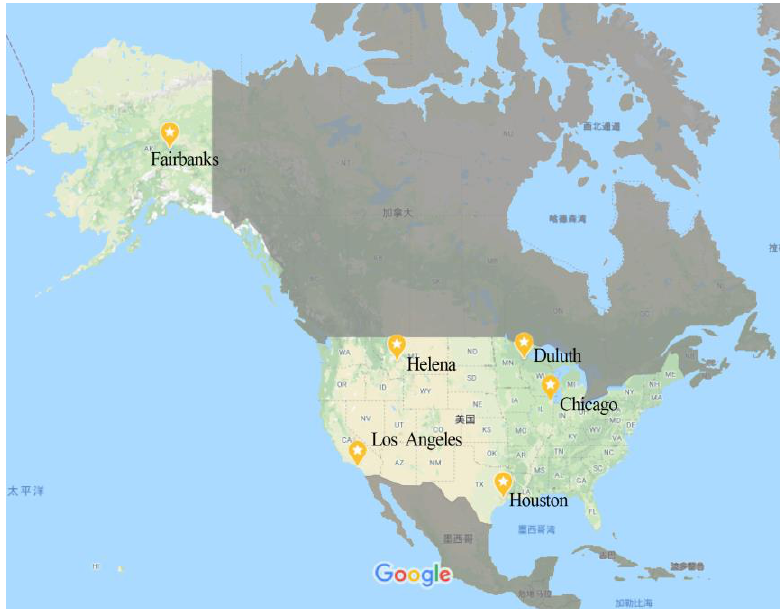
Figure 4. Location of typical cities in the United States.